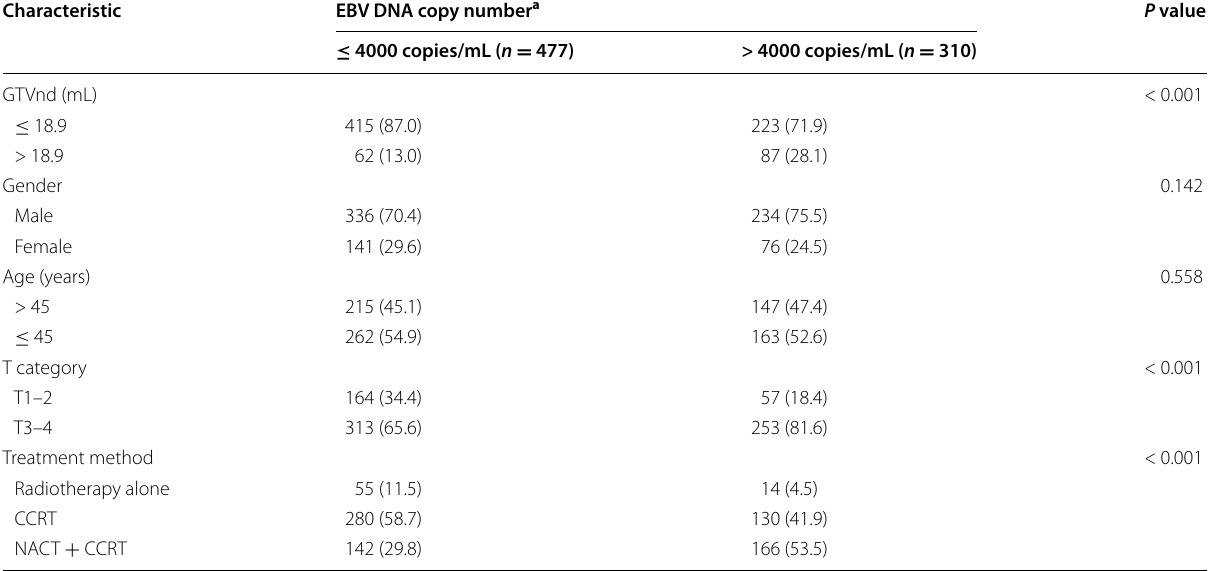
EBV pretreatment Epstein–Barr virus, GTVnd gross tumor volume of lymph nodes, CCRT concurrent chemoradiotherapy, NACT neoadjuvant chemotherapy a